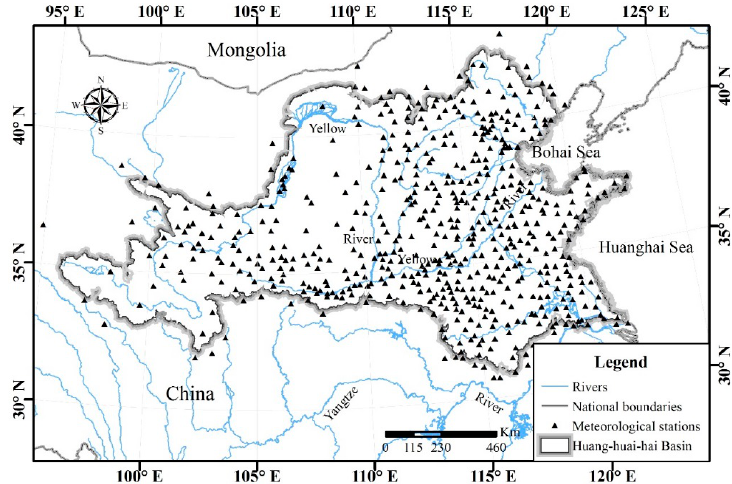
Figure 1. Location of the Huang-huai-hai River Basin and the meteorological stations.